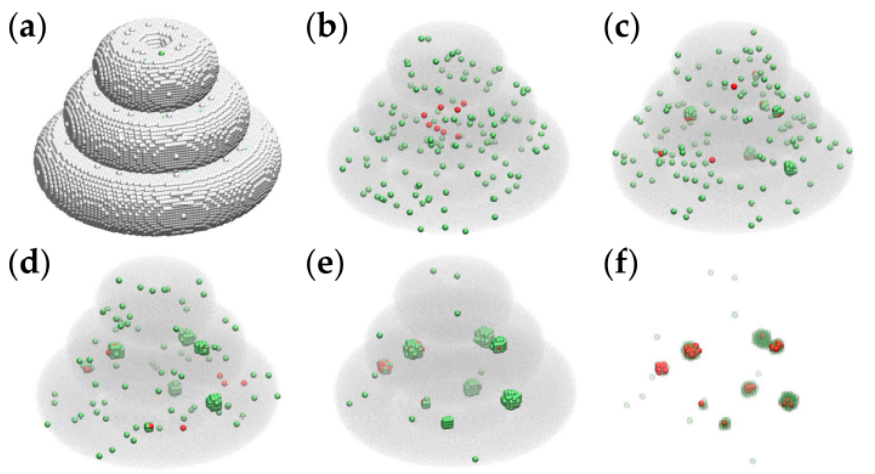
Figure 7. Representative MMC simulation snapshots of the evolution of a triple-layered tissue construct built on a cubic lattice at the scale of 1:3. Tumor cells and peritumoral cells are represented by red and green spheres, respectively. ( a ) The initial state containing about 1.4 × 10 5 cell-sized volume elements of the embedding hydrogel is pictured as silver spheres. ( b ) The initial state, showing the hydrogel as a translucent gray medium, contains 8 tumor cells and 137 peritumoral cells; ( c ) the configuration obtained by running the simulation for 2 × 10 3 MCS; ( d ) the result of 5 × 10 3 MCS; ( e ) the outcome of 10 4 MCS; ( f ) the result of 10 4 MCS with the embedding hydrogel removed, and the peritumoral cells represented as transparent green spheres—to visualize the relative positions of malignant cells and peritumoral cells.